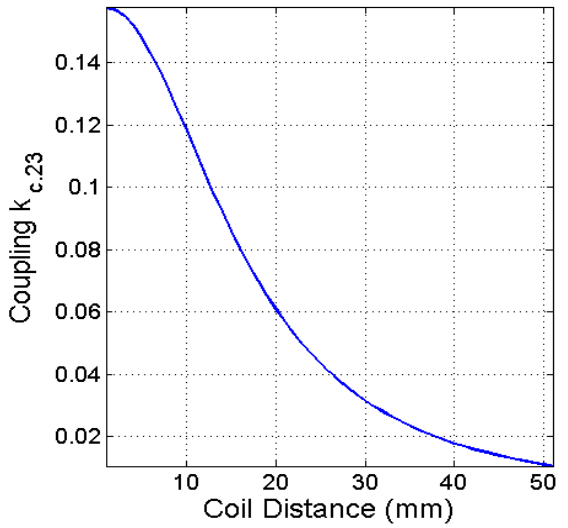
Figure 7. Mutual coupling ( k c. 23 ) versus distance.